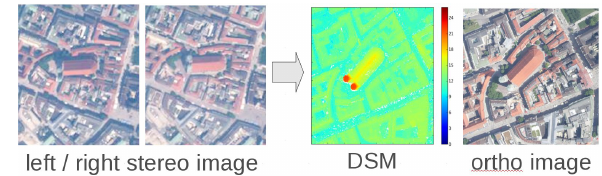
Figure 8: Multistereo processing chain: Input are two or more images of the same area, output is the DSM and an ortho image